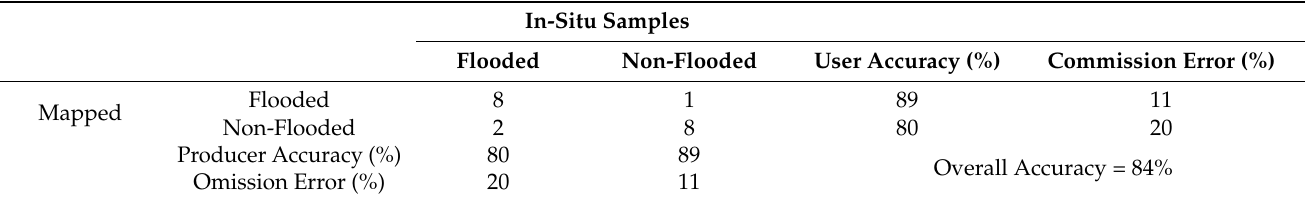
Table 1. Confusion matrix of the identification of the flooded and non-flooded wetlands using test